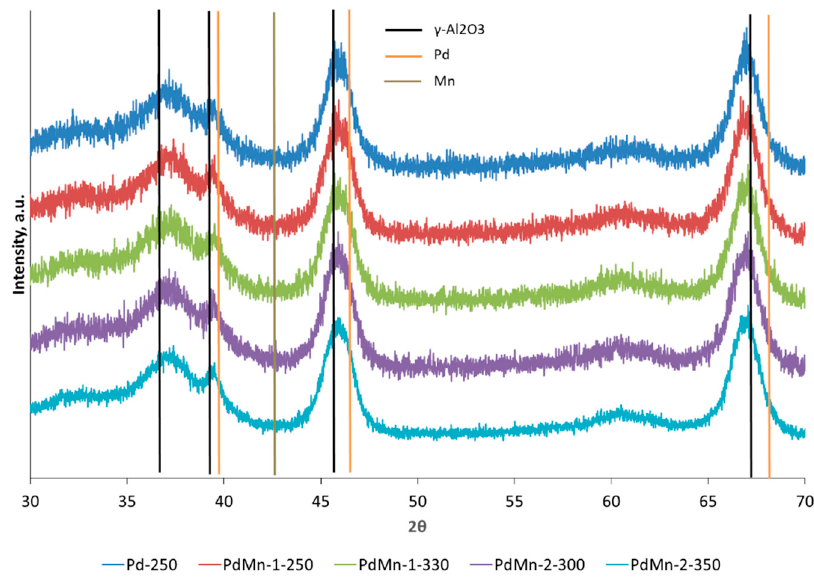
Figure 4. XRD patterns of Pd-Mn/Al 2 O 3 samples.